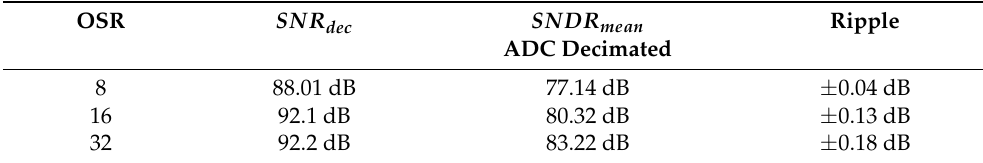
Table 3. Decimation filter parameters. The ripple is simulated for f in < 0.9 Bw